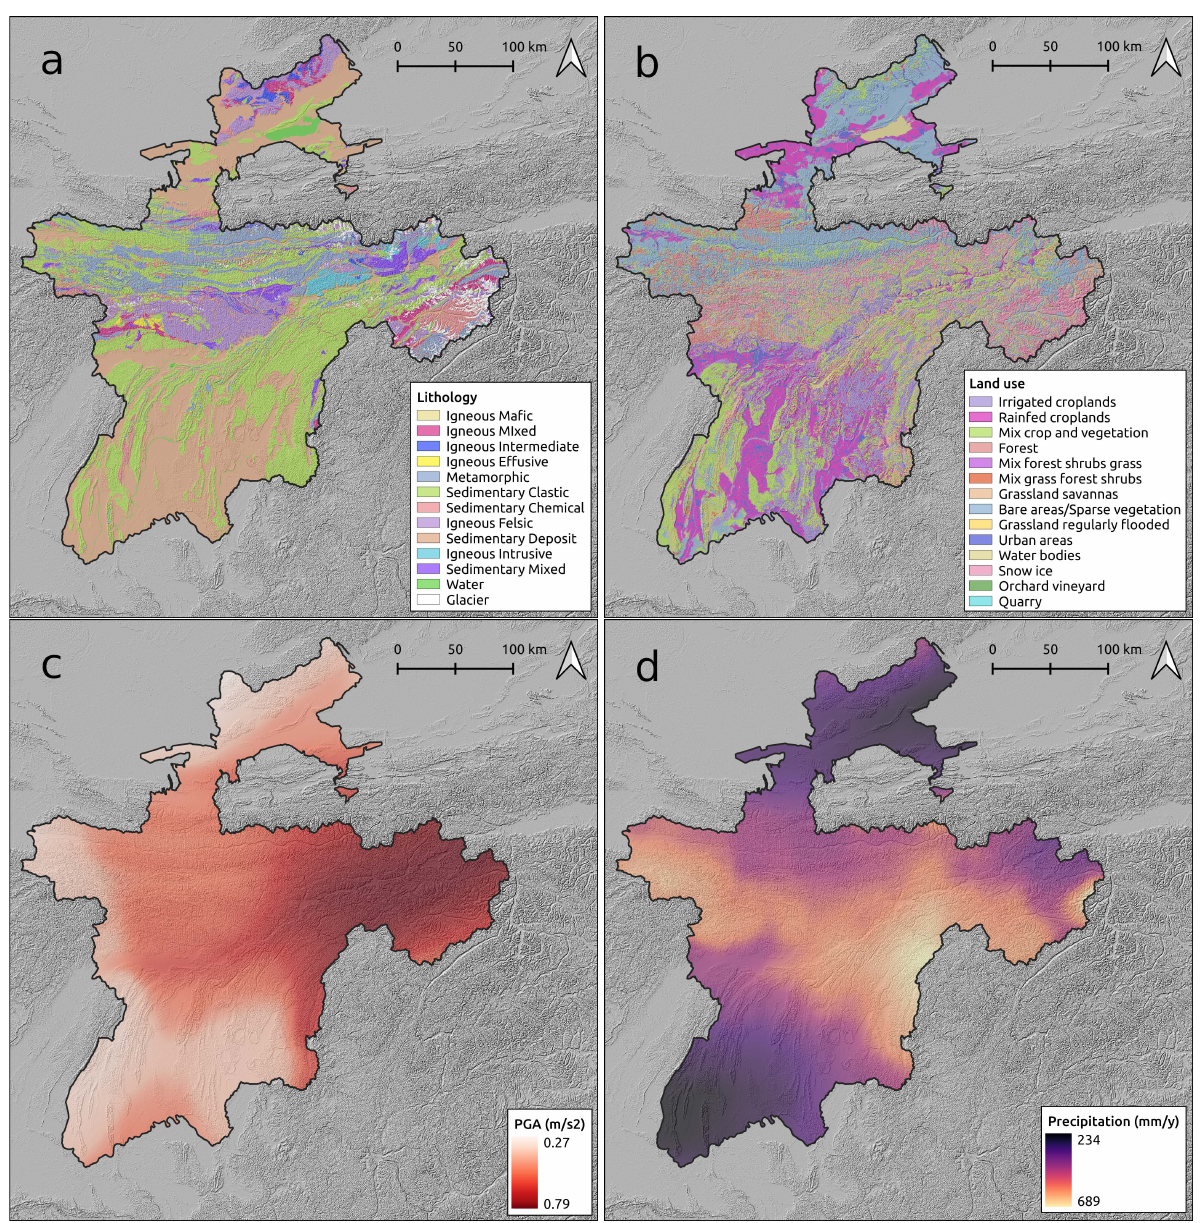
Figure 2. Four of the nine covariates used in this study: ( a ) Land use, ( b ) lithology, ( c ) PGA maps of the 475-year Return Period, and ( d ) average annual precipitation (over a 10-year